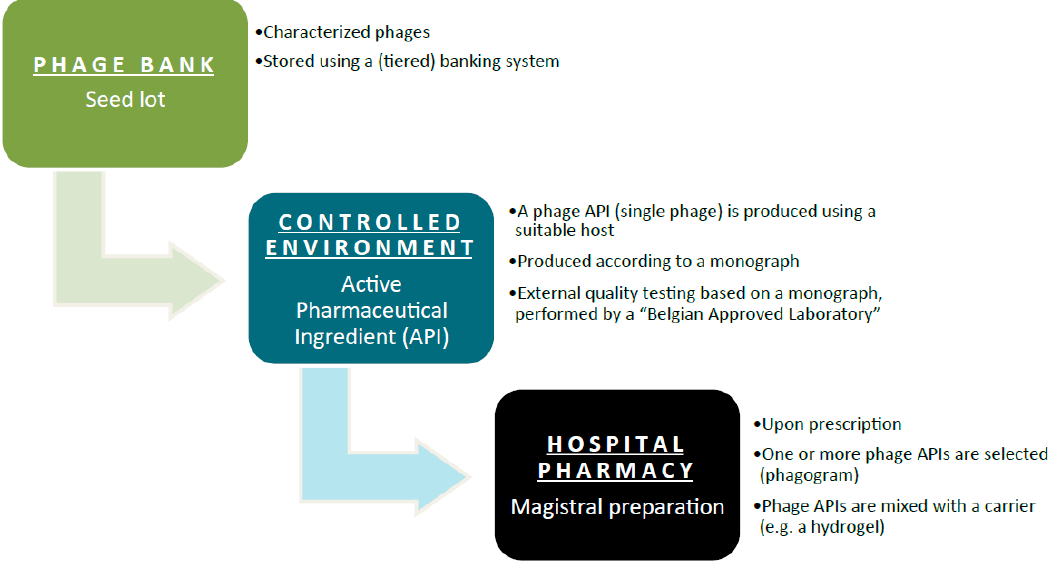
Figure 1. General flowchart of the magistral phage medicine process.